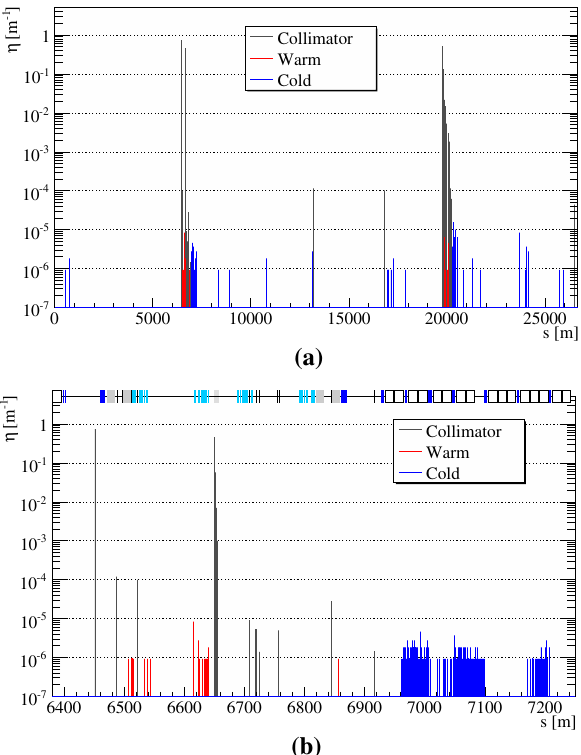
Fig. 5 Simulated beam-loss pattern for the IR3 layout with Cry 1 at 5 σ . The whole LHC ( a ), zoom of the IR3 insertion ( b ) (1 p = 9 . 1 × 10 − 7 m − 1 )